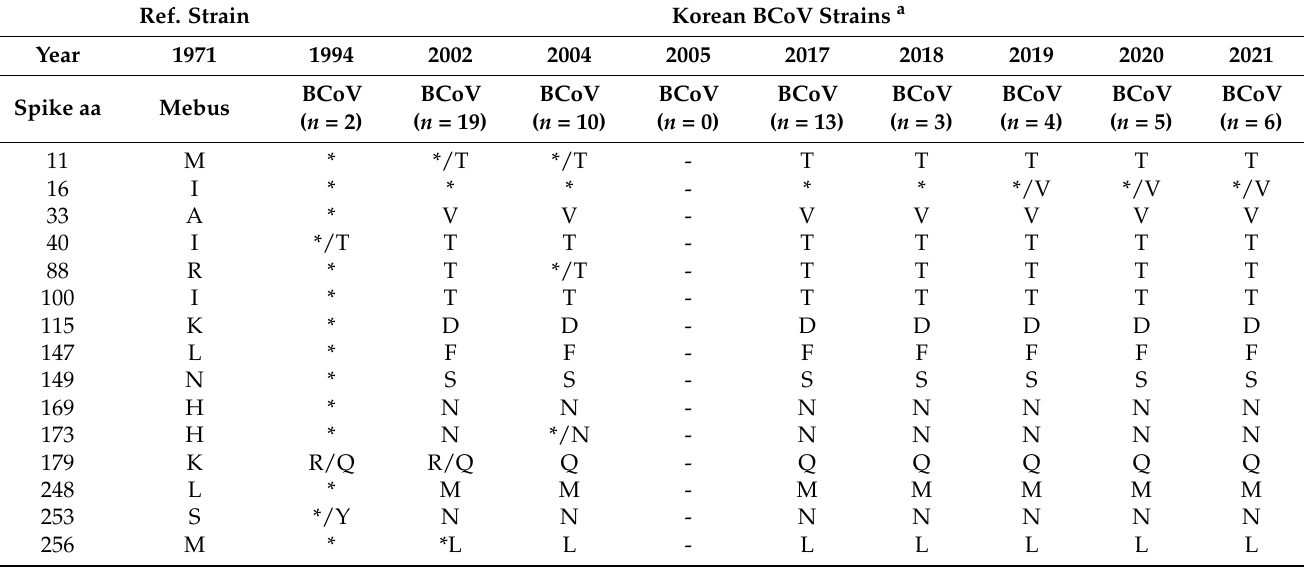
Table 2. Comparison of the deduced amino acid sequences for the Spike genes of Korean BCoVs. Ref.